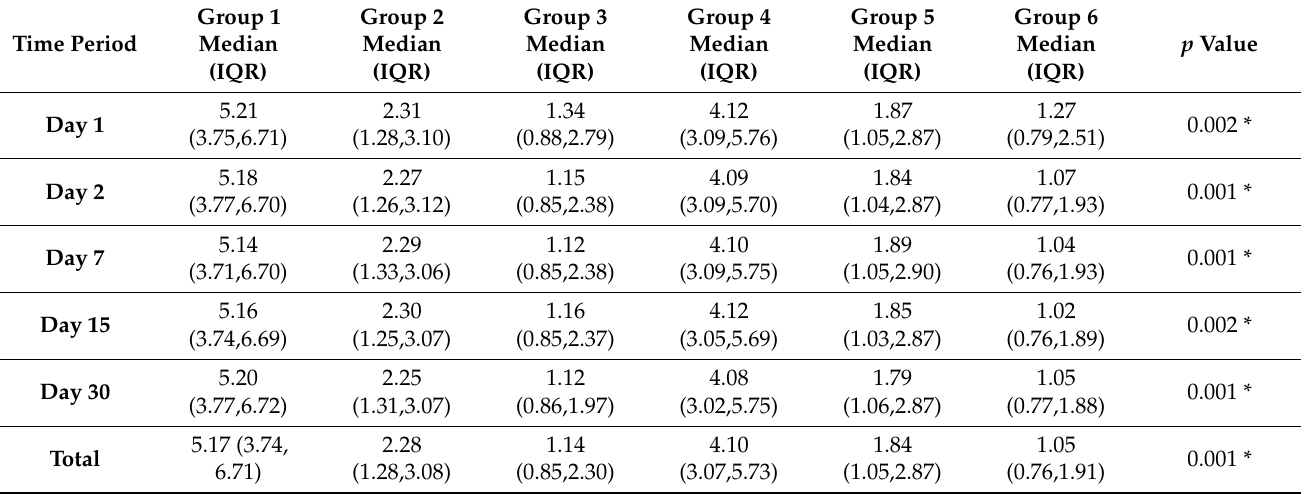
Table 2. Comparison of all study groups using Kruskal–Wallis